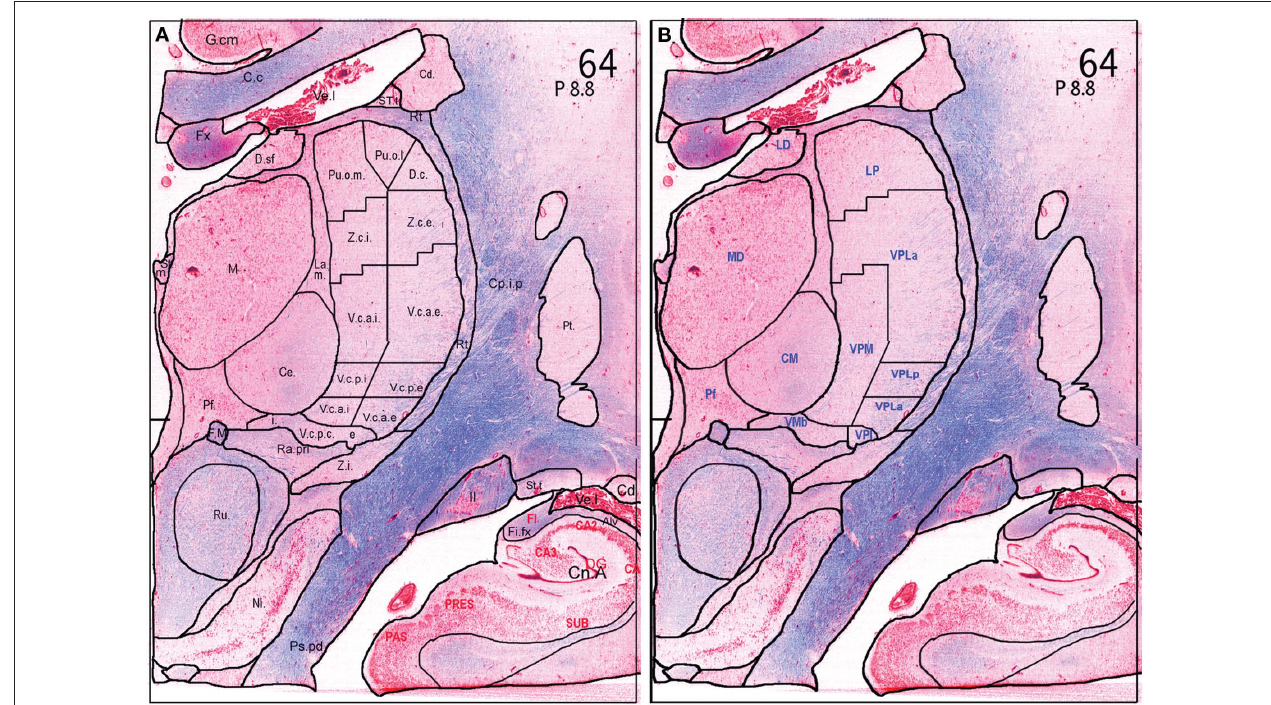
Figure 1 | Outline of nuclei of the human thalamus on a coronal Myelin–Nissl stained section. The section is taken at the level of the sensory thalamus. Thalamic nuclei are outlined using the terminology in Schaltenbrand’s atlas according to Hassler (A) , with homologous outlines using the terminology of Hirai and Jones